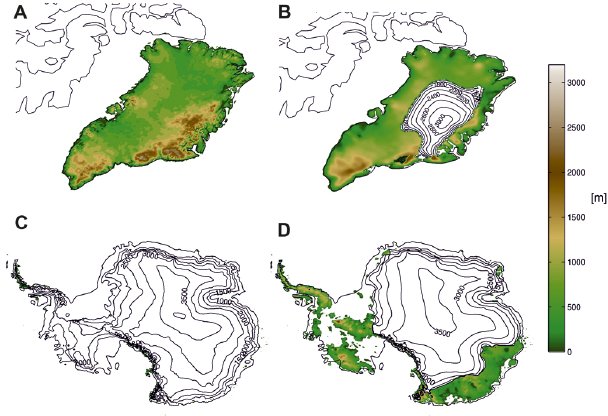
Fig. 3. Ice sheet model initial conditions showing (a) an ice-free Greenland, (b) PRISM3 ice over Greenland (Hill, 2009; Dowsett et al., 2010), (c) the modern Antarctic ice sheet topography (m) and (d) PRISM3 Antarctic ice.